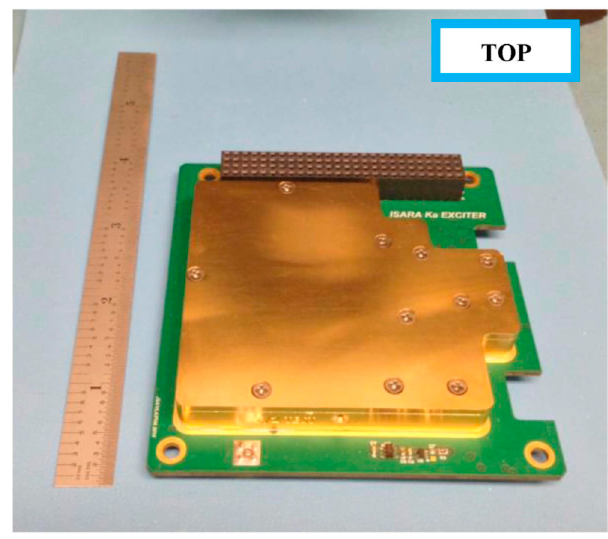
Figure 10. ISARA transmitter module [13].